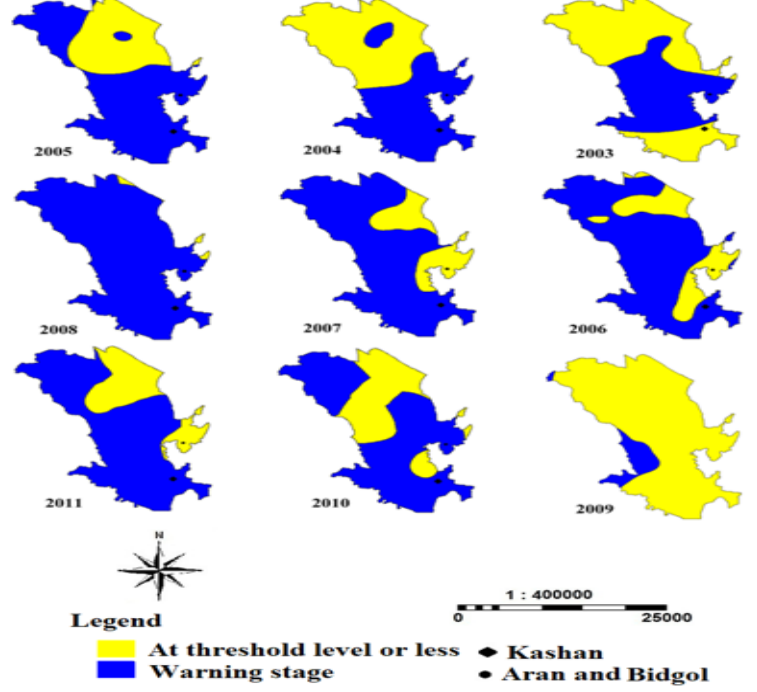
Figure 5. The areas under warning stage based on groundwater drop (2003-2011)